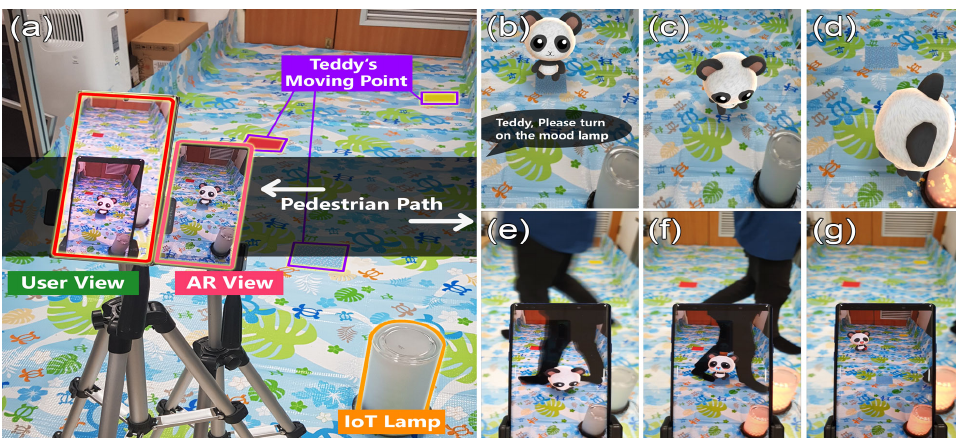
Figure 3. ( a ) Experimental set-up [7]. ( b – d ) The sequence of interactions to command the pet to turn on the lamp [7]. ( e – g ) The situation wherein a pedestrian walks by and intrudes on the augmented reality (AR)